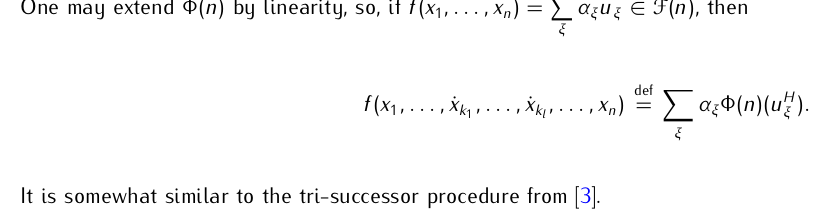
One may extend Φ( n ) by linearity, so, if f ( x 1 ,...,x n ) =